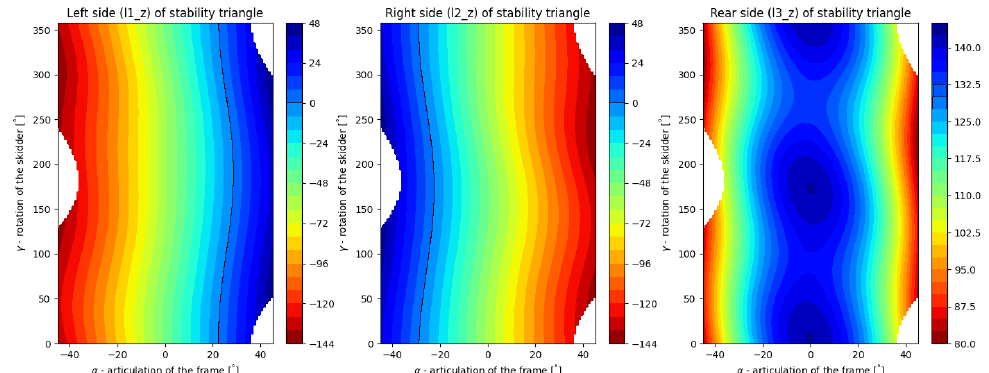
Figure 10. Comparison of stability for the half-filled tank (C3 config.) and full tank with additional front load (C4 config.). The plot displays the same values as the plots above, however, color bars show values computed as C3 minus C4 distances [mm] of gravity vector to tipping lines. Positive values mean that the C3 configuration is more stable than C4. Negative values mean that the C4 configuration is more stable than